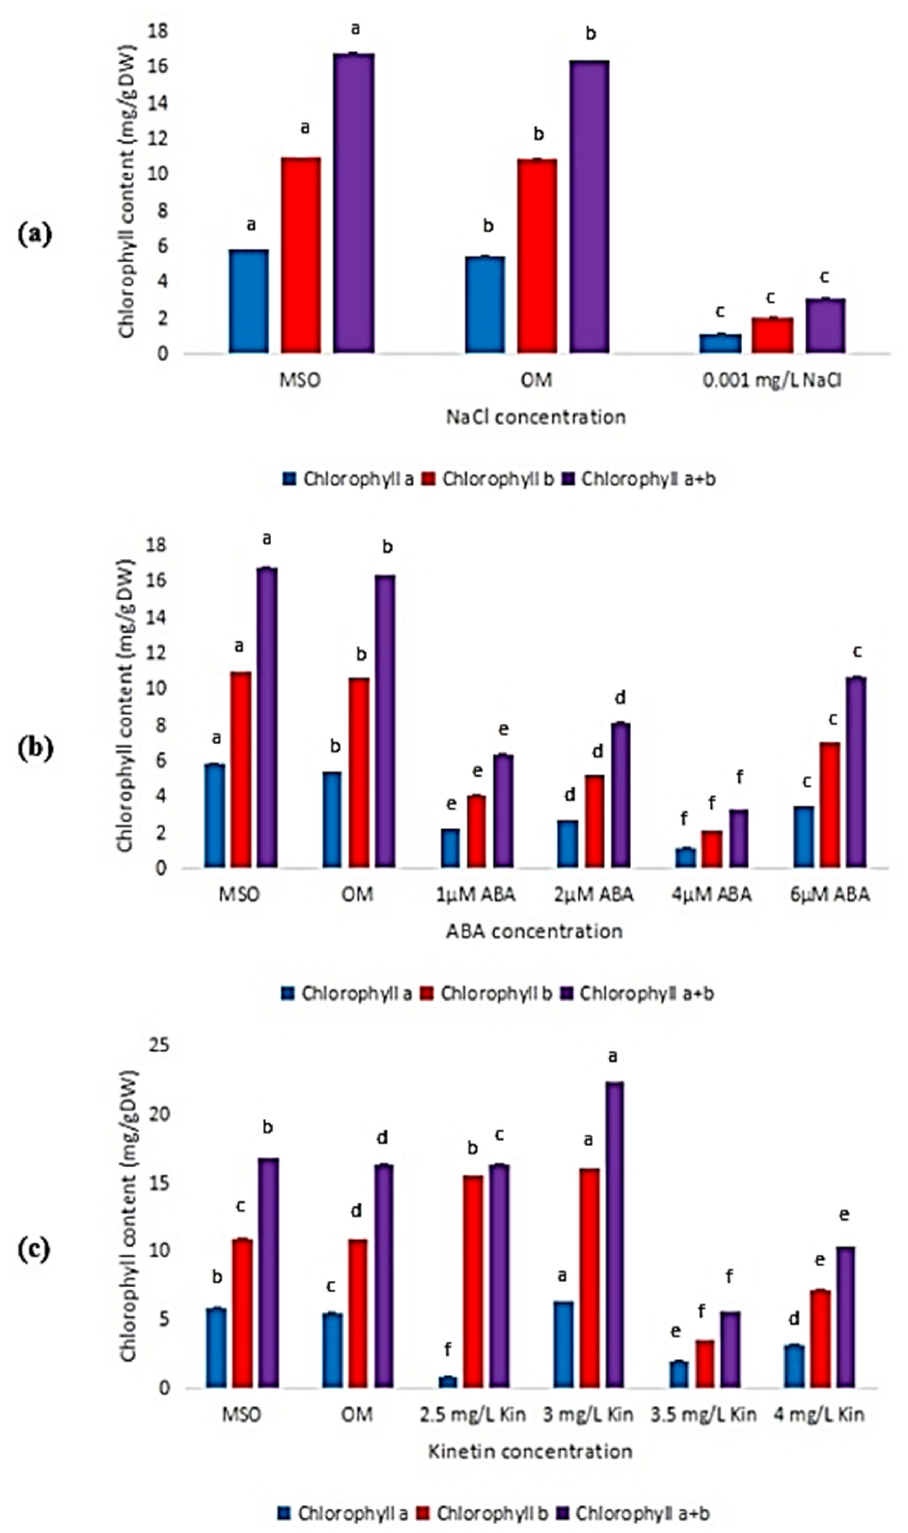
Figure 6. Chlorophyll content in plants exposed to: ( a ) salt stress (0.001 mg/L NaCl); ( b ) ABA; ( c ) high kinetin levels. Means with different letters are significantly different at p < 0.05 according to Duncan’s multiple range test (DMRT), subject to different type of measurement conducted.